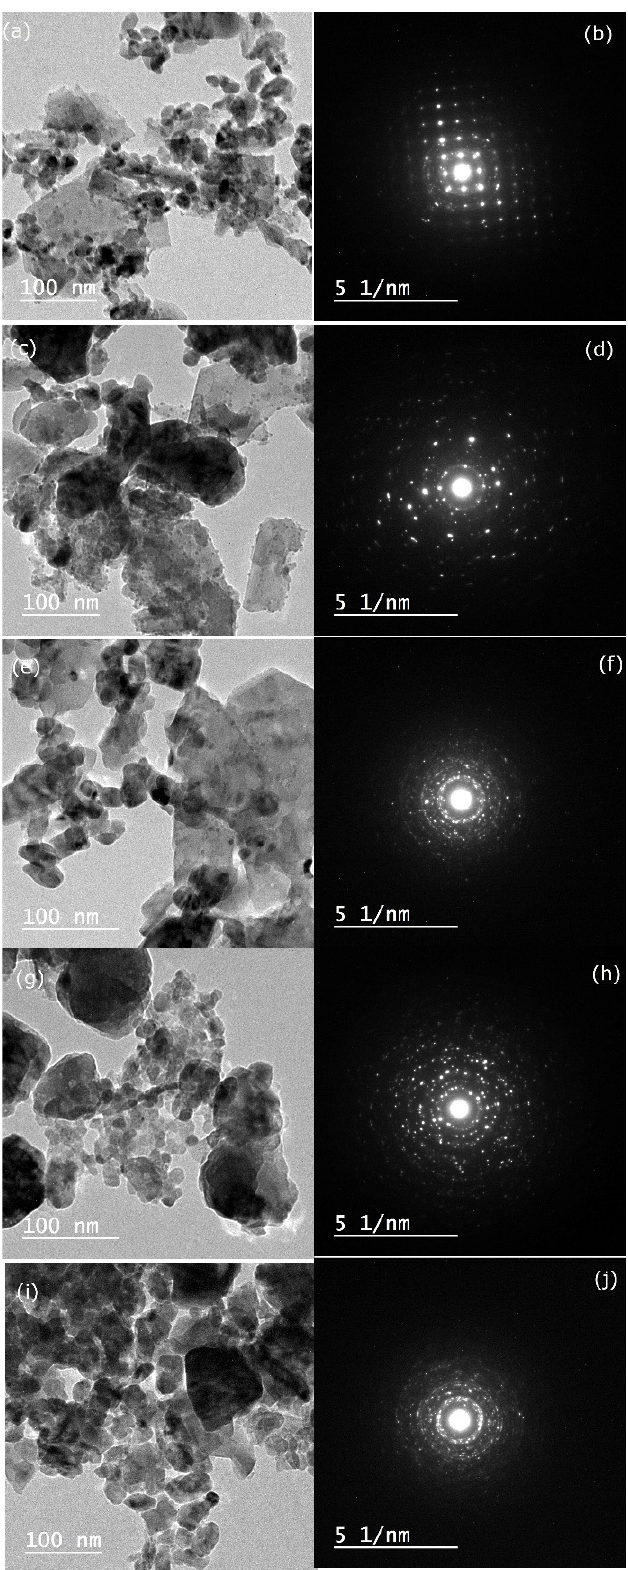
Figure 6. The TEM photos of ZC0 ( a , b ), ZC25 ( c , d ), ZC50 ( e , f ), ZC75 ( g , h ), and ZC100 ( i , j )